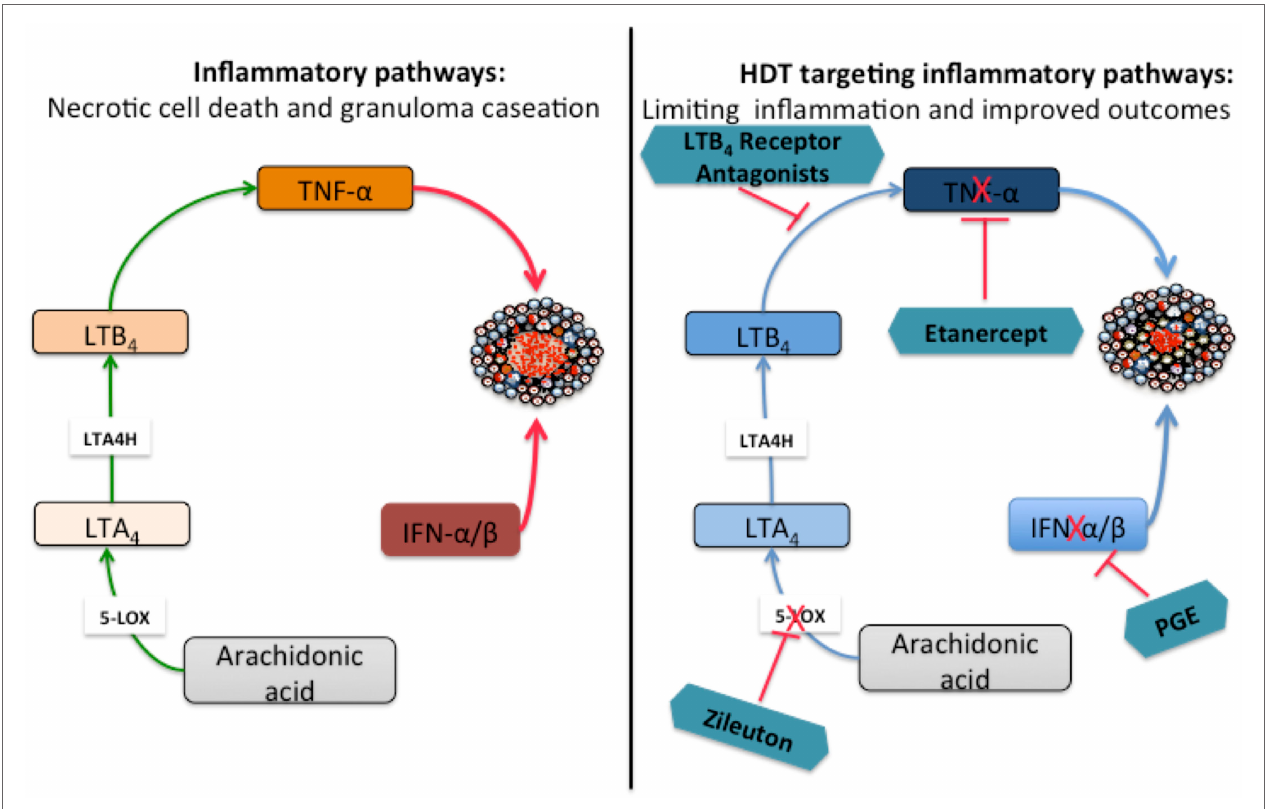
FiGURe 3 | Targeting inflammatory proteins as host-directed therapies (HDTs) for TB to ameliorate tissue inflammation . Arachidonic acid (AA) is metabolized by 5-lipoxygenase (5-LO) to produce leukotriene A4 (LTA 4 ), a substrate in the subsequent step that is catalyzed by leukotriene A4 hydrolase (LTA4H) to produce the highly inflammatory leukotriene B4 (LTB 4 ). High levels of LTB 4 drive excessive TNF- α production by macrophages that may trigger necrotic cell death. Necrotic cell death leads to granuloma dissociation resulting in the formation of caseums and eventually cavities after the necrotic center collapses into the airways. Type I IFNs block the production of host protective IL-1 α and IL-1 β in vitro and in vivo resulting in reduced production of PGE2. Targeting specific inflammatory proteins with chemical inhibitors or antibodies could be a possible HDT aimed at limiting tissue inflammation and improve treatment outcomes. The proof-of- principle for the interventions depicted in the schematic has been established in animal